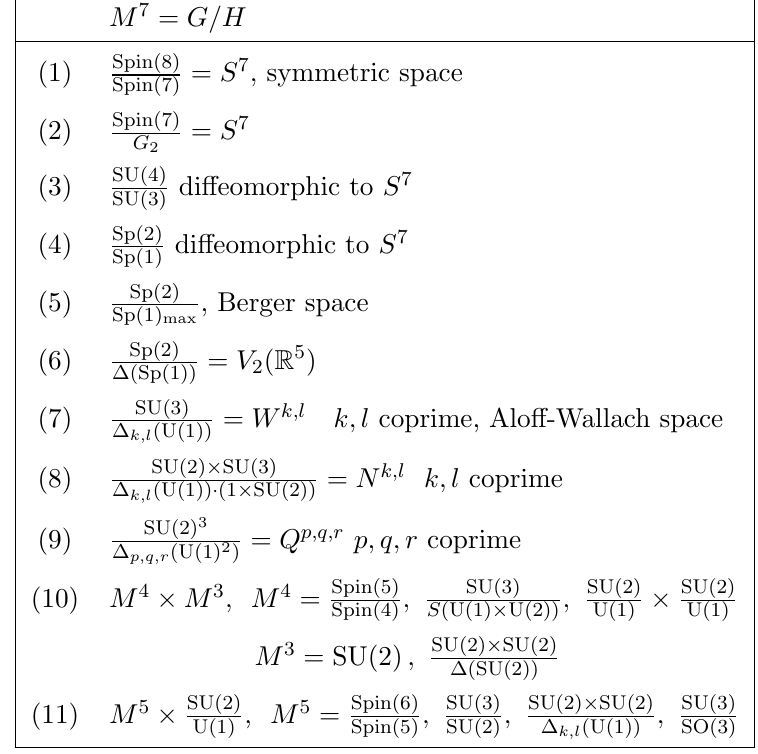
Table 3 . 7-dimensional compact, simply connected, homogeneous